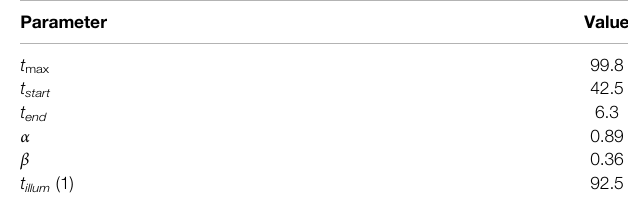
TABLE 1 | Parameters of the optimized 3-oscillator